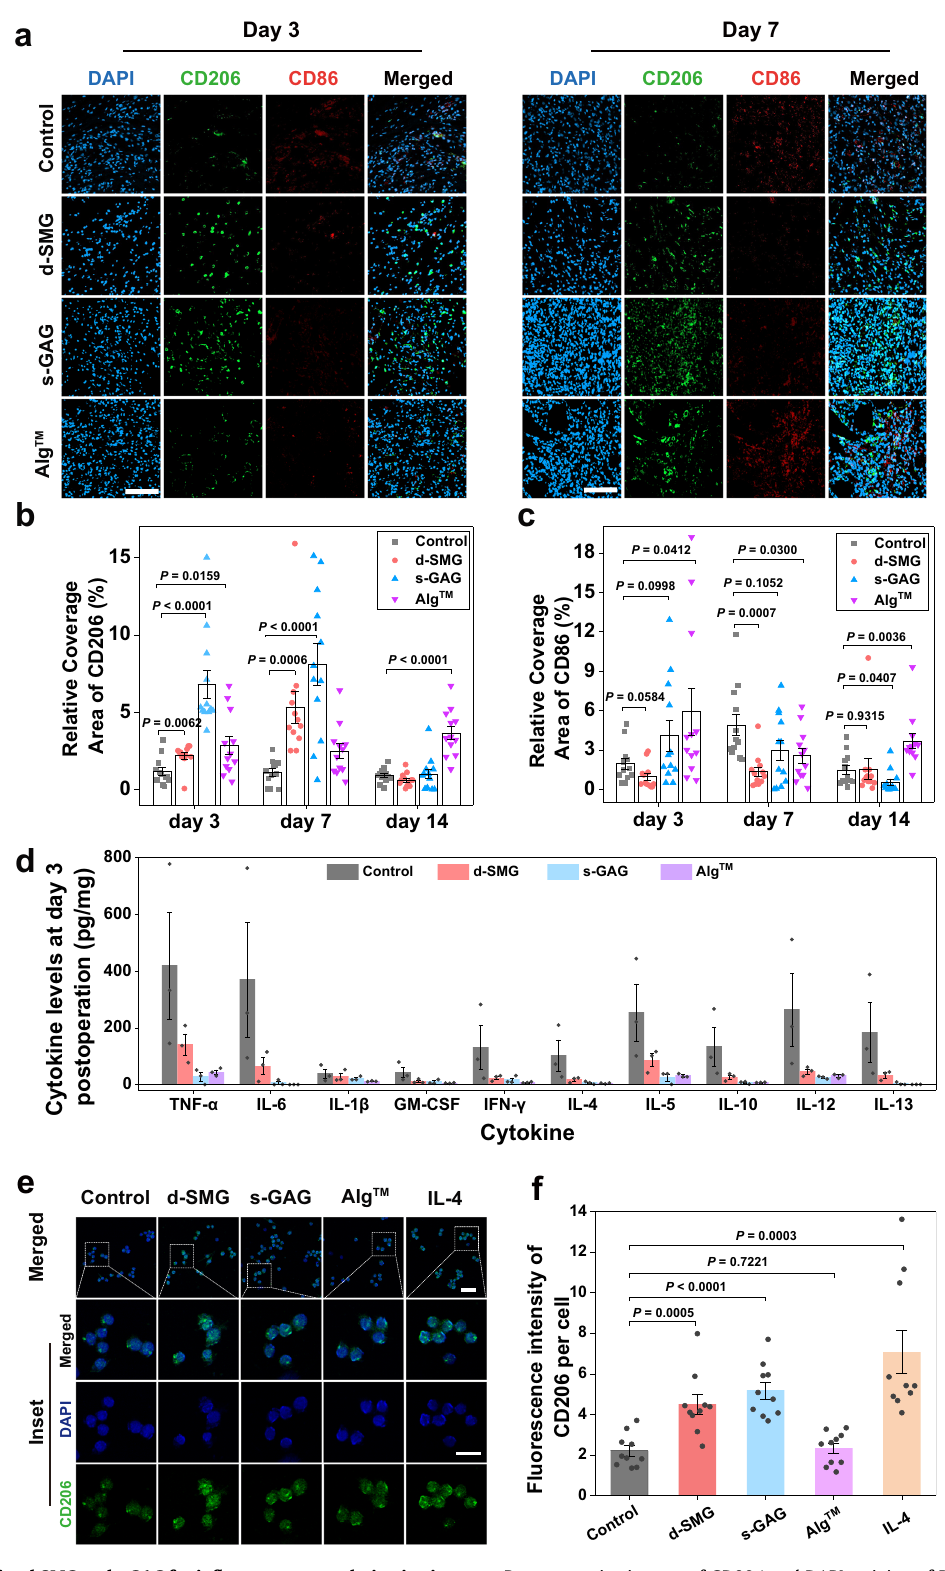
Fig.7|Effectsof A.fulica d-SMGands-GAGforin fl ammatoryregulationinvivo. a Representative image of CD206 and CD86 immunostaining in wound tissue on day3and7. b Quanti fi cationofCD206 + areainthewoundtissue( n =12biologically independent samples in each group). c Quanti fi cation of CD86 + area in the wound tissue(( n =12biologicallyindependentsamplesineachgroup). d Cytokinelevelsin wound tissue on day 3 ( n =3 biologically independent samples in each group).